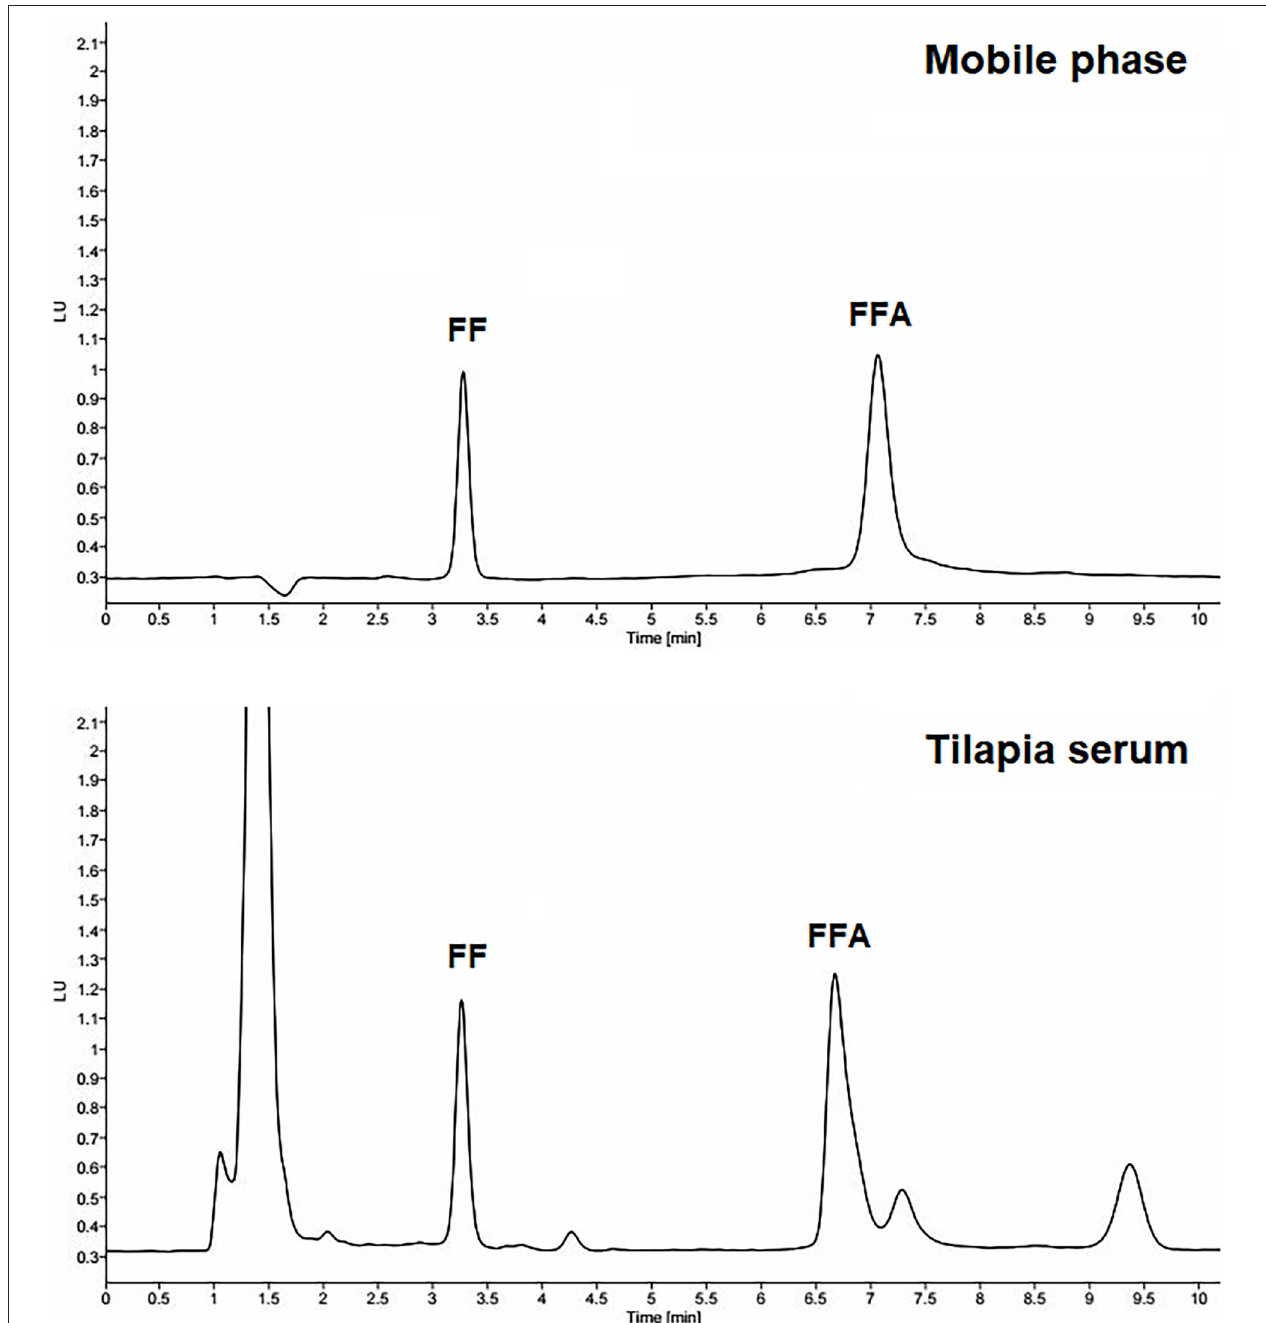
FIGURE 1 | The representative HPLC chromatograms of 2 µ g/mL reference standards of florfenicol (FF) and florfenicol amine (FFA) in the mobile phase and tilapia serum.